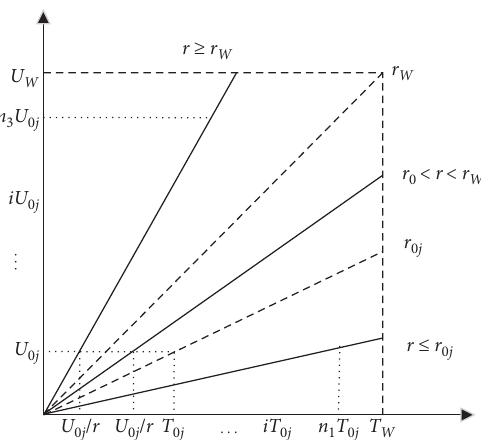
Figure 5: Two-dimensional imperfect PM cycle under r